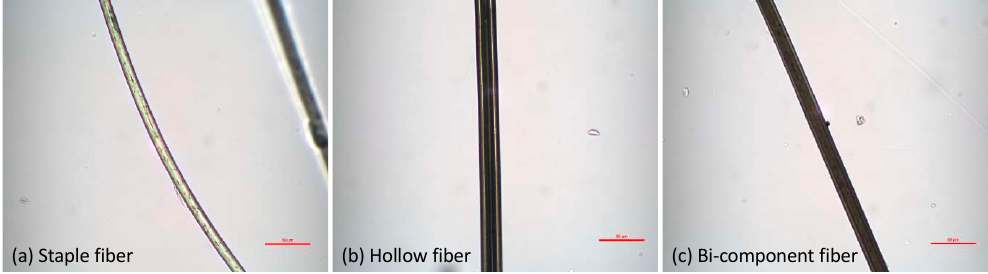
Figure 3. Longitudinal images of fibers: ( a ) staple fiber; ( b) hollow fiber; ( c ) bi-component fiber.